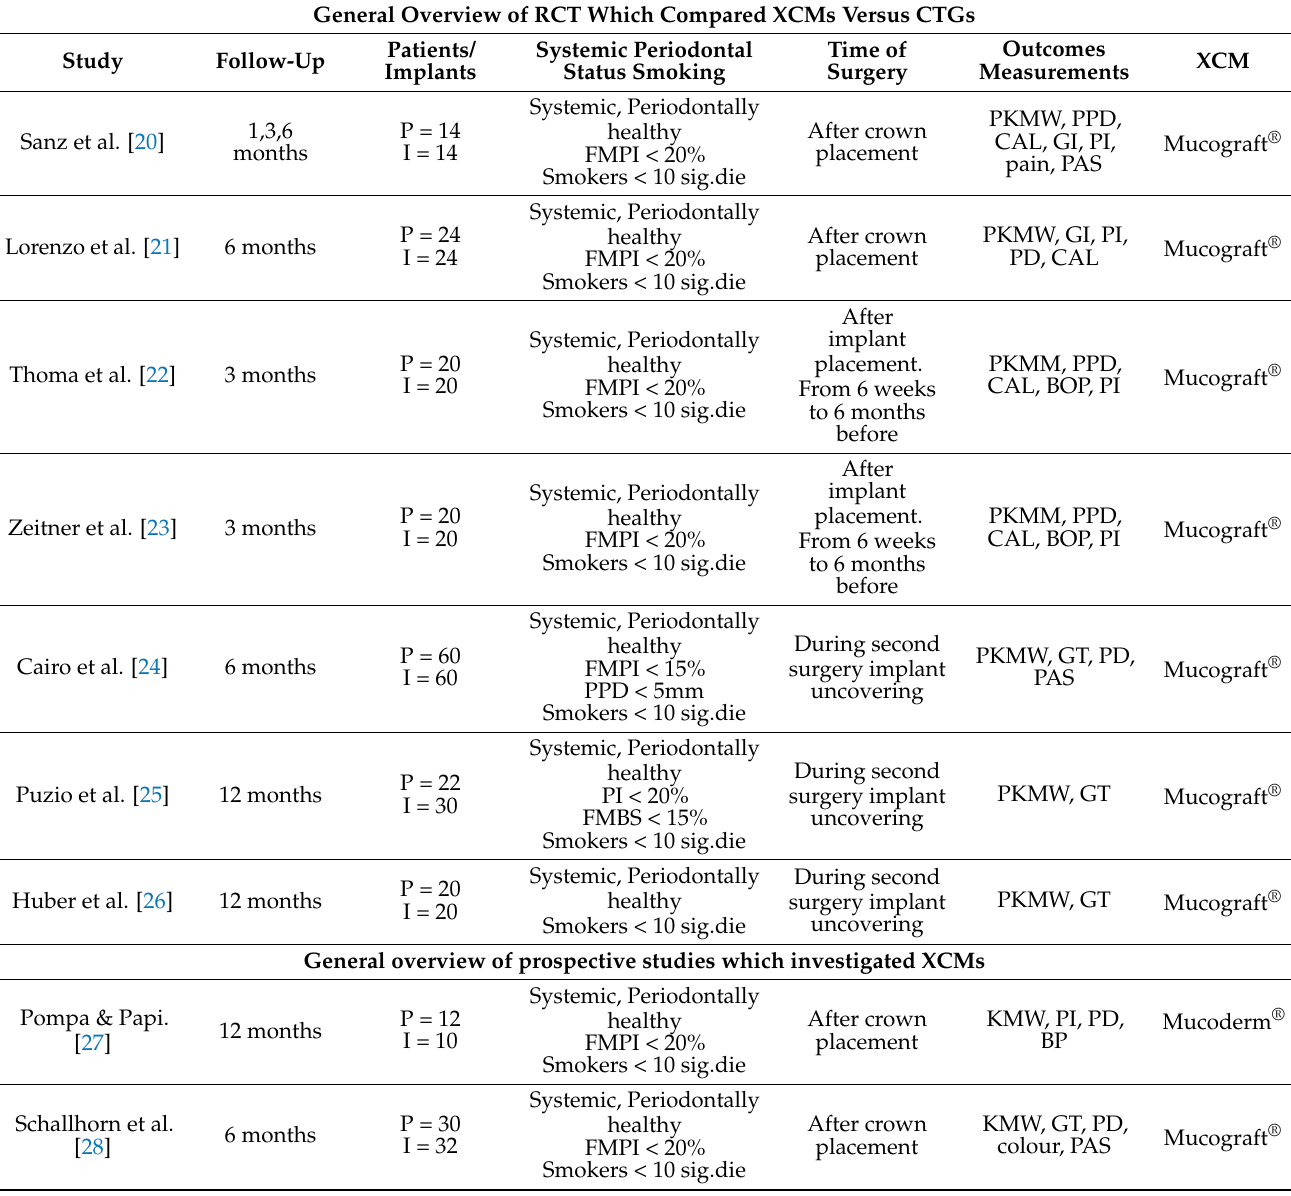
Table 2. General overview of the included RCT which compared CTG (control) versus XCM (test). General Overview of RCT Which Compared XCMs Versus CTGs